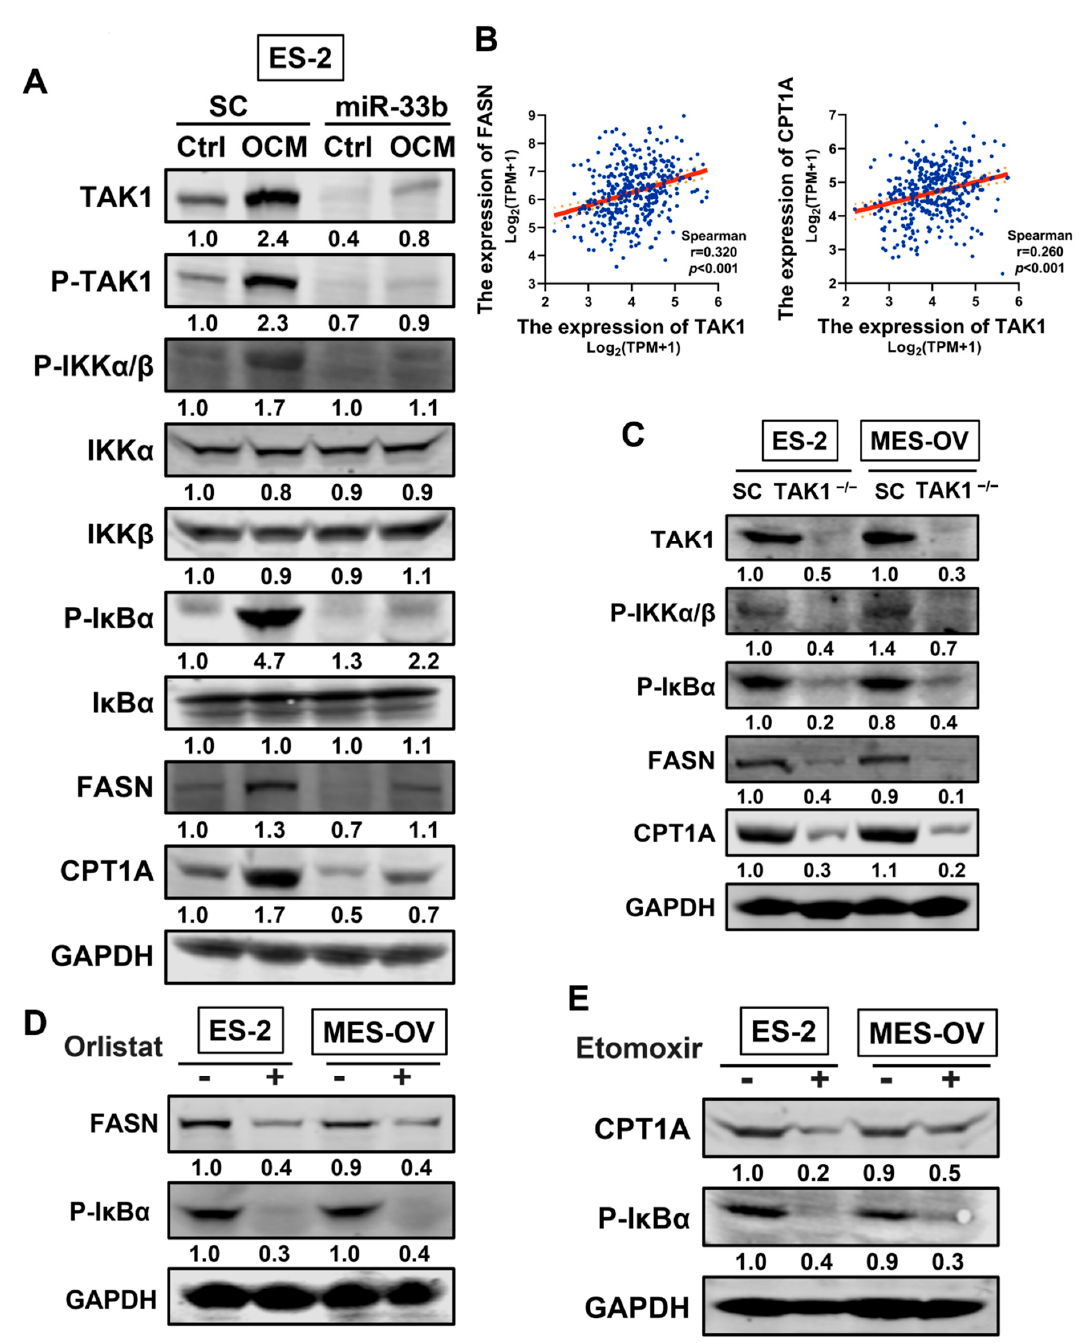
Figure 5. miR-33b targeting TAK1/FASN/CPT1A/NF- κ B signaling axis in ovarian cancer cells. ( A ) Scrambled control or stable miR-33b overexpressing ES-2 and MES-OV cells were treated with OCM or 1% FBS normal medium for 24 h. Protein contents of TAK1, P-TAK1, P-IKK α / β , IKK α , IKK β , P-I κ B α , I κ B α , FASN, CPT1A, GAPDH were examined by WB. ( B ) Scatter plots depicting the correlation between TAK1 and FASN (right panel) or CPT1A (left panel) in TCGA-OV dataset.